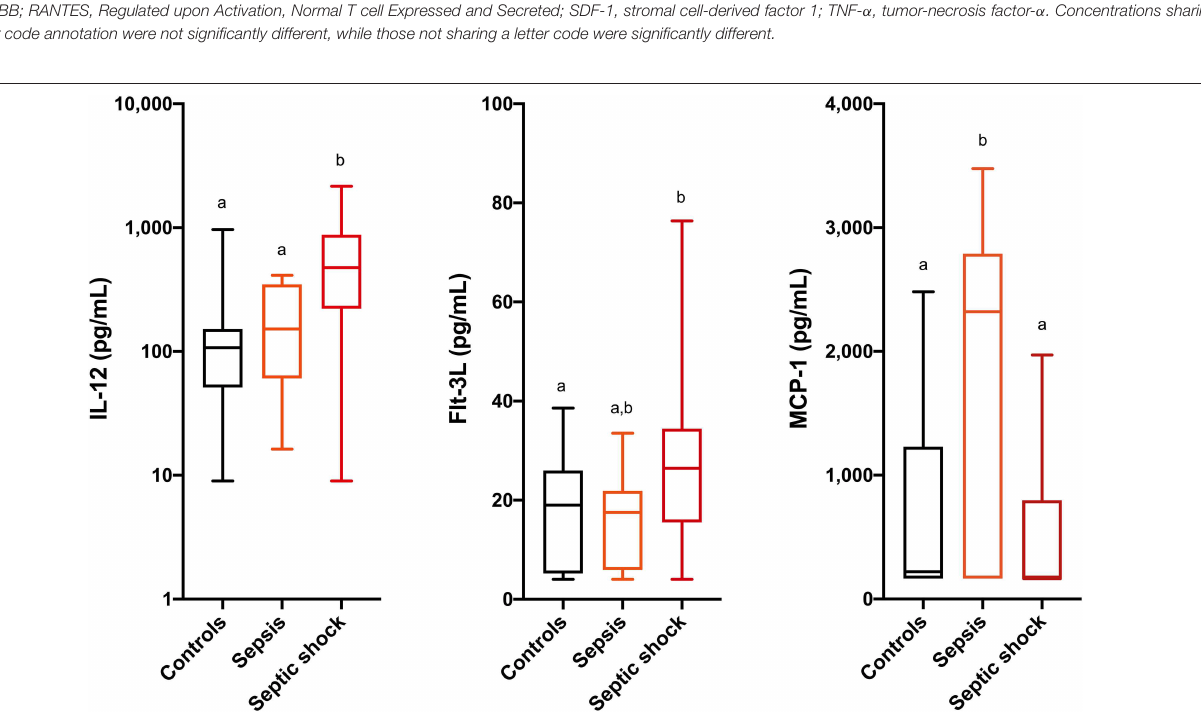
FIGURE 2 | Box and whisker plots for the concentrations of interleukin-12 (IL-12), FMS-like tyrosine kinase-3 ligand (Flt-3L) and monocyte chemoattractant protein-1 (MCP-1) in healthy cats, cats with sepsis, and cats with septic shock. Concentrations sharing a letter code annotation were not significantly different, while those not sharing a letter code were significantly different. For cytokines with measured concentrations below those covered by the standard curve, values for the assay lower limit of detection were imputed. Hence the figures appear truncated due to imputation of the lower limits of detection. Note that the Y-axis scale for IL-12 is logarithmic, while the Y-axis scales for Flt-3L and MCP-1 are